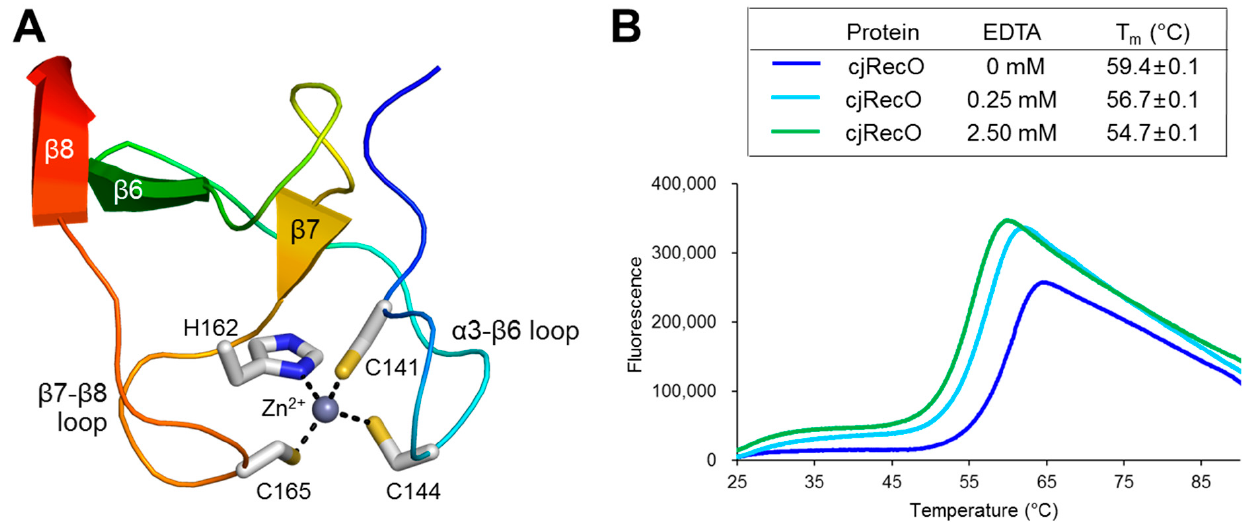
Figure 3. Zn 2+ -binding capacity of cjRecO. ( A ) Zn 2+ coordination by cjRecO residues. The Zn 2+ ion and Zn 2+ -coordinating cjRecO residues are represented by a light blue sphere and gray sticks, respectively, in the cjRecO ZnD structure (rainbow ribbons). The orientation of the figure is similar to that shown in the right side of Figure 1A. ( B ) Thermal shift assay of cjRecO in the absence and presence of the divalent ion-chelating reagent EDTA. The T m value of the cjRecO protein decreased in the presence of EDTA, suggesting that Zn 2+ binding enhances the protein stability of cjRecO. The data in the figure are representative of three independent experiments that yielded similar results. T m values are shown as means ± S.D. from three independent experiments.